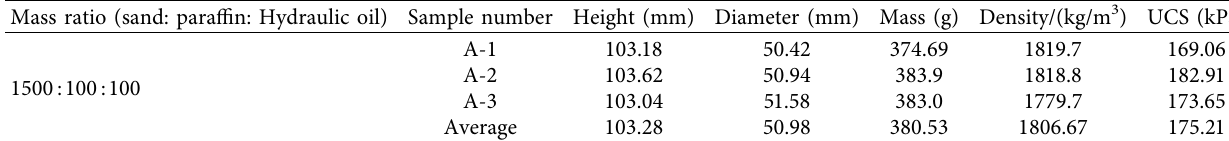
Table 1: Uniaxial compression test